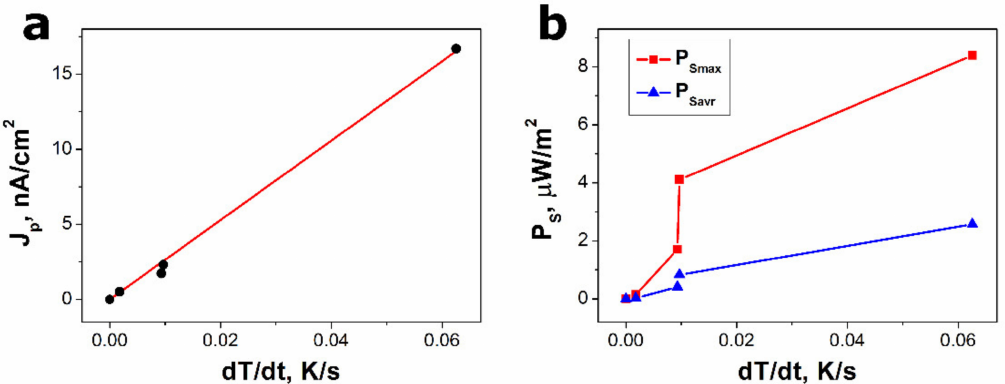
Figure 6. The output pyroelectric current density ( a ) and the surface power density ( b ) of the SbSI– TiO 2 pyroelectric nanogenerator as a function of the temperature change rate. The red line in Figure ( a ) represents the best fit dependence (3). The red and blue experimental points in Figure ( b ) show the values of the maximum and average surface power density,